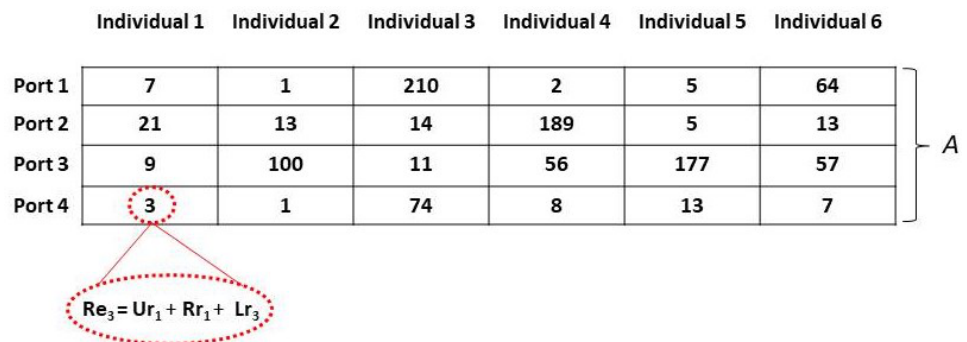
Figure 9. Representation of the b best solutions in a population of six individuals within a